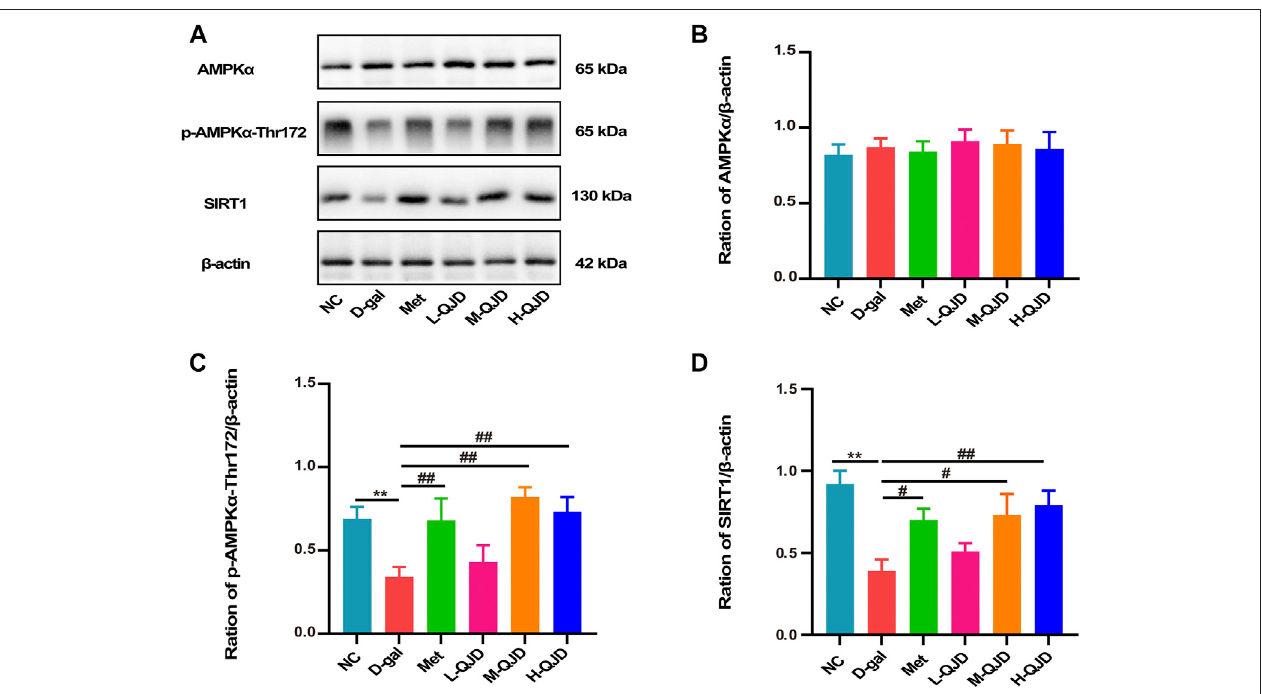
FIGURE 5 | QJD activated the AMPK/SIRT1 signaling pathway in the hippocampus of D-gal – induced mice. (A) Representative Western blot bands showing the protein expression levels of AMPK α , p -AMPK α -Thr172, and SIRT1 in the hippocampus. (B) Relative protein expression level of AMPK α . (C) Relative protein expression level of p -AMPK α -Thr172. (D) Relative protein expression level of SIRT1. All data were presented as mean ± SEM ( n (cid:1) 6/group). ** p < 0.01 vs. NC group; # p < 0.05 and ## p < 0.01 vs. D-gal